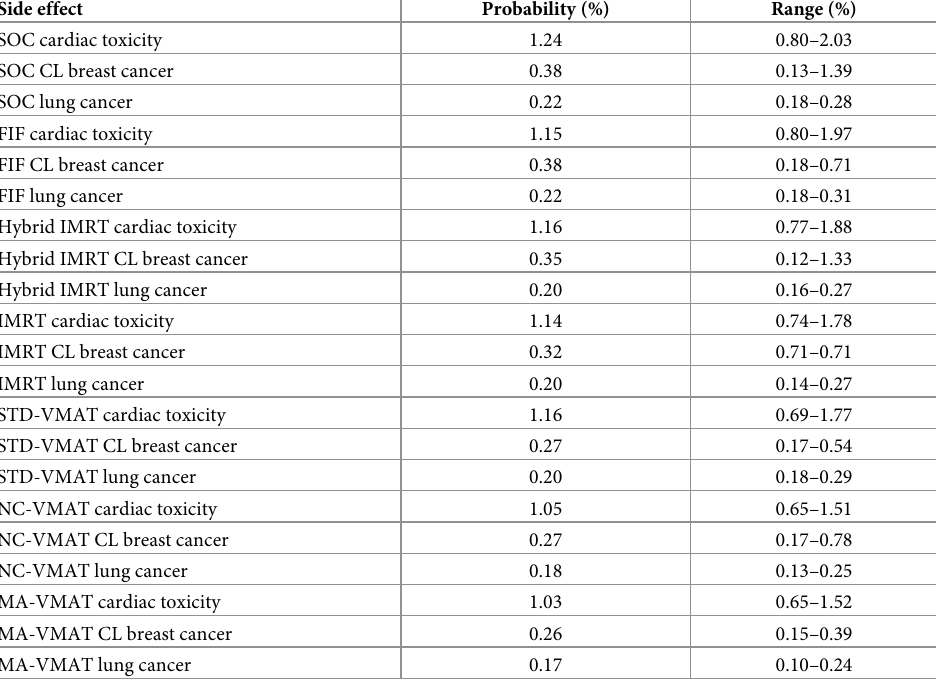
Table 3. Calculated annual probabilities of developing radiogenic side effects for the 65-year-old cohort from a previous study